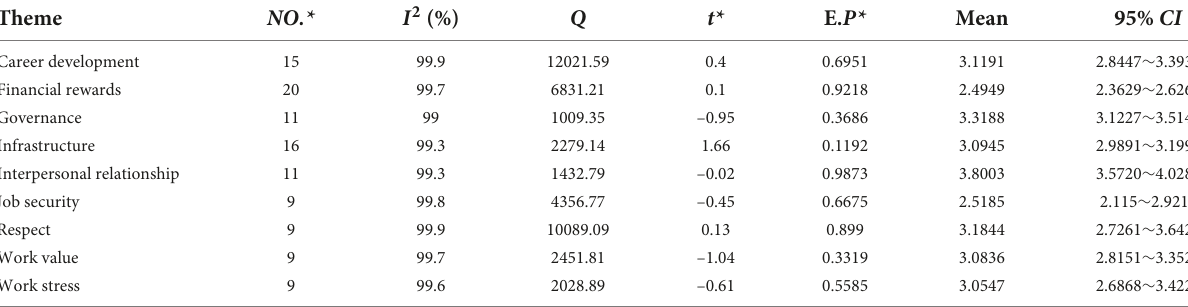
TABLE 3 Meta-analysis summary of score values of different